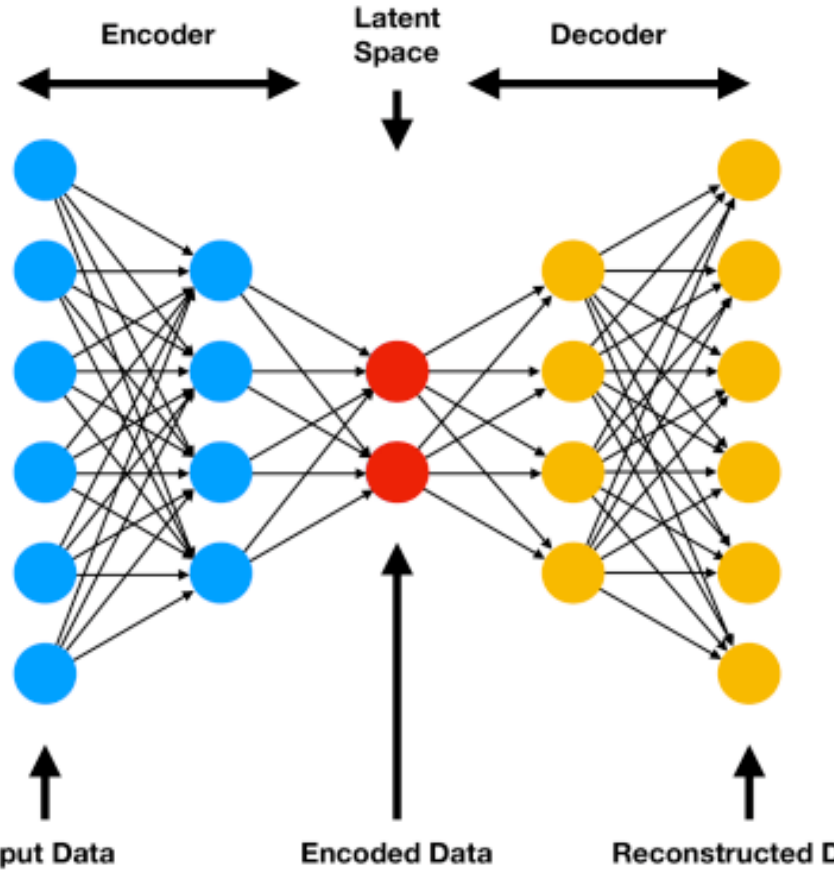
Figure 2. The autoencoder architecture can be considered a form of representation learning where the mid-level encoded data are interpreted as output. Reproduced with permission